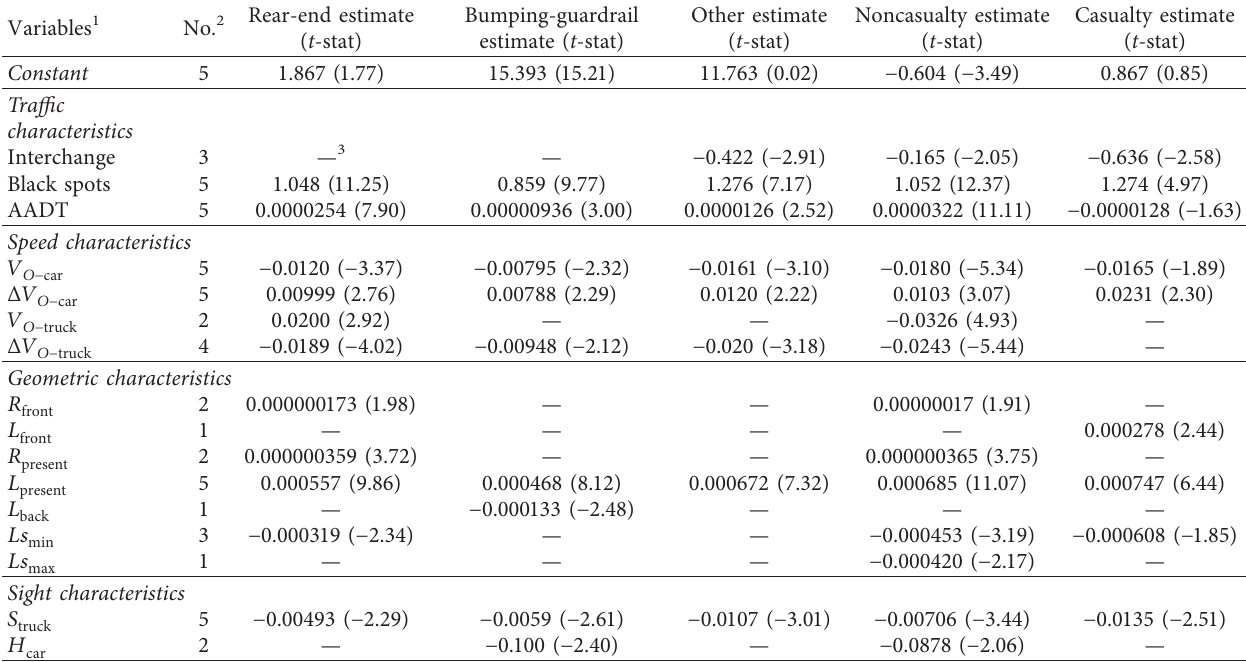
Table 4: Random-parameter multivariate negative binomial model estimation